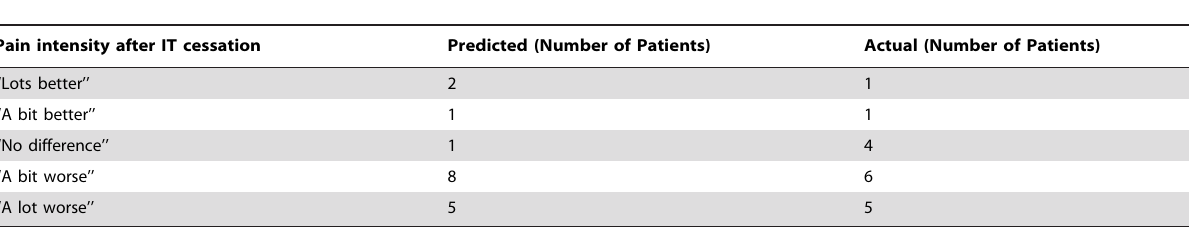
Table 2. Predicted versus actual pain intensity 3 months after ceasing IT therapy.